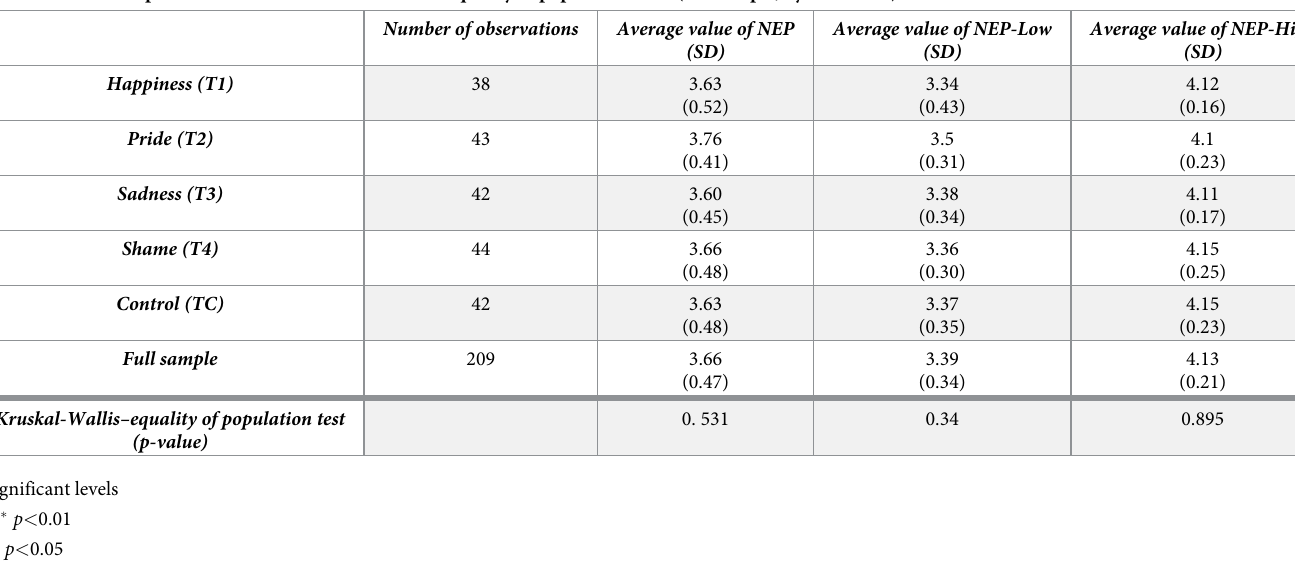
Table 2. Scores for pro-environmental motivations and equality of population tests (full sample, by